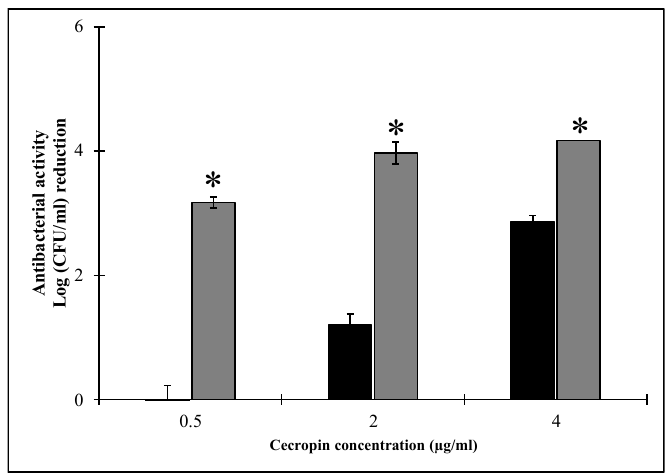
Figure 5. The antibacterial activity of HEWL (500 µg/mL) in combination with cecropin A (grey bars) against exponentially grown Salmonella enterica ATCC 35664. Black bars represent controls conducted by challenging bacterial cells to three ascending concentrations of cecropin A. LB expo- nentially grown bacterial cells were pelted, diluted to 10 6 CFU/mL and resuspended in 10 mM po- tassium phosphate buffer. The prepared culture was then subjected to a combination of 500 µg/mL HEWL with escalating doses of 0.5, 2 and 4 µg/mL of cecropin A. A parallel experiment was con- ducted by treating the prepared culture with the same doses of cecropin A. Negative controls were performed using 10 mM potassium phosphate buffer instead of protein. Each value represents the mean ± standard deviation from three independent replicates. Asterisks represent the statistical dif- ferences from the values for cecropin A-treated cells (Student’s t test; * p < 0.05). Similarly, the previous combinations were evaluated against stationary grown Sal- monella enterica ATCC 35664. The challenged bacteria were found refractory to the bacte- ricidal effect of HEWL alone (final concentration up to 1000 µg/mL) and CecA (up to 4 µg/mL) when used individually. Nevertheless, combining 500 µg/mL HEWL with 0.5 µg/mL CecA statistically reduced ( p < 0.05) the stationary grown bacterial cell count by 1.73 ± 0.16 log unit. The overall antibacterial activity of HEWL was further increased upon increasing CecA concentration in a dose-dependent manner with the activity of 3.18 ± 0.23 log in the presence of 4 µg/mL CecA (Figure 6).